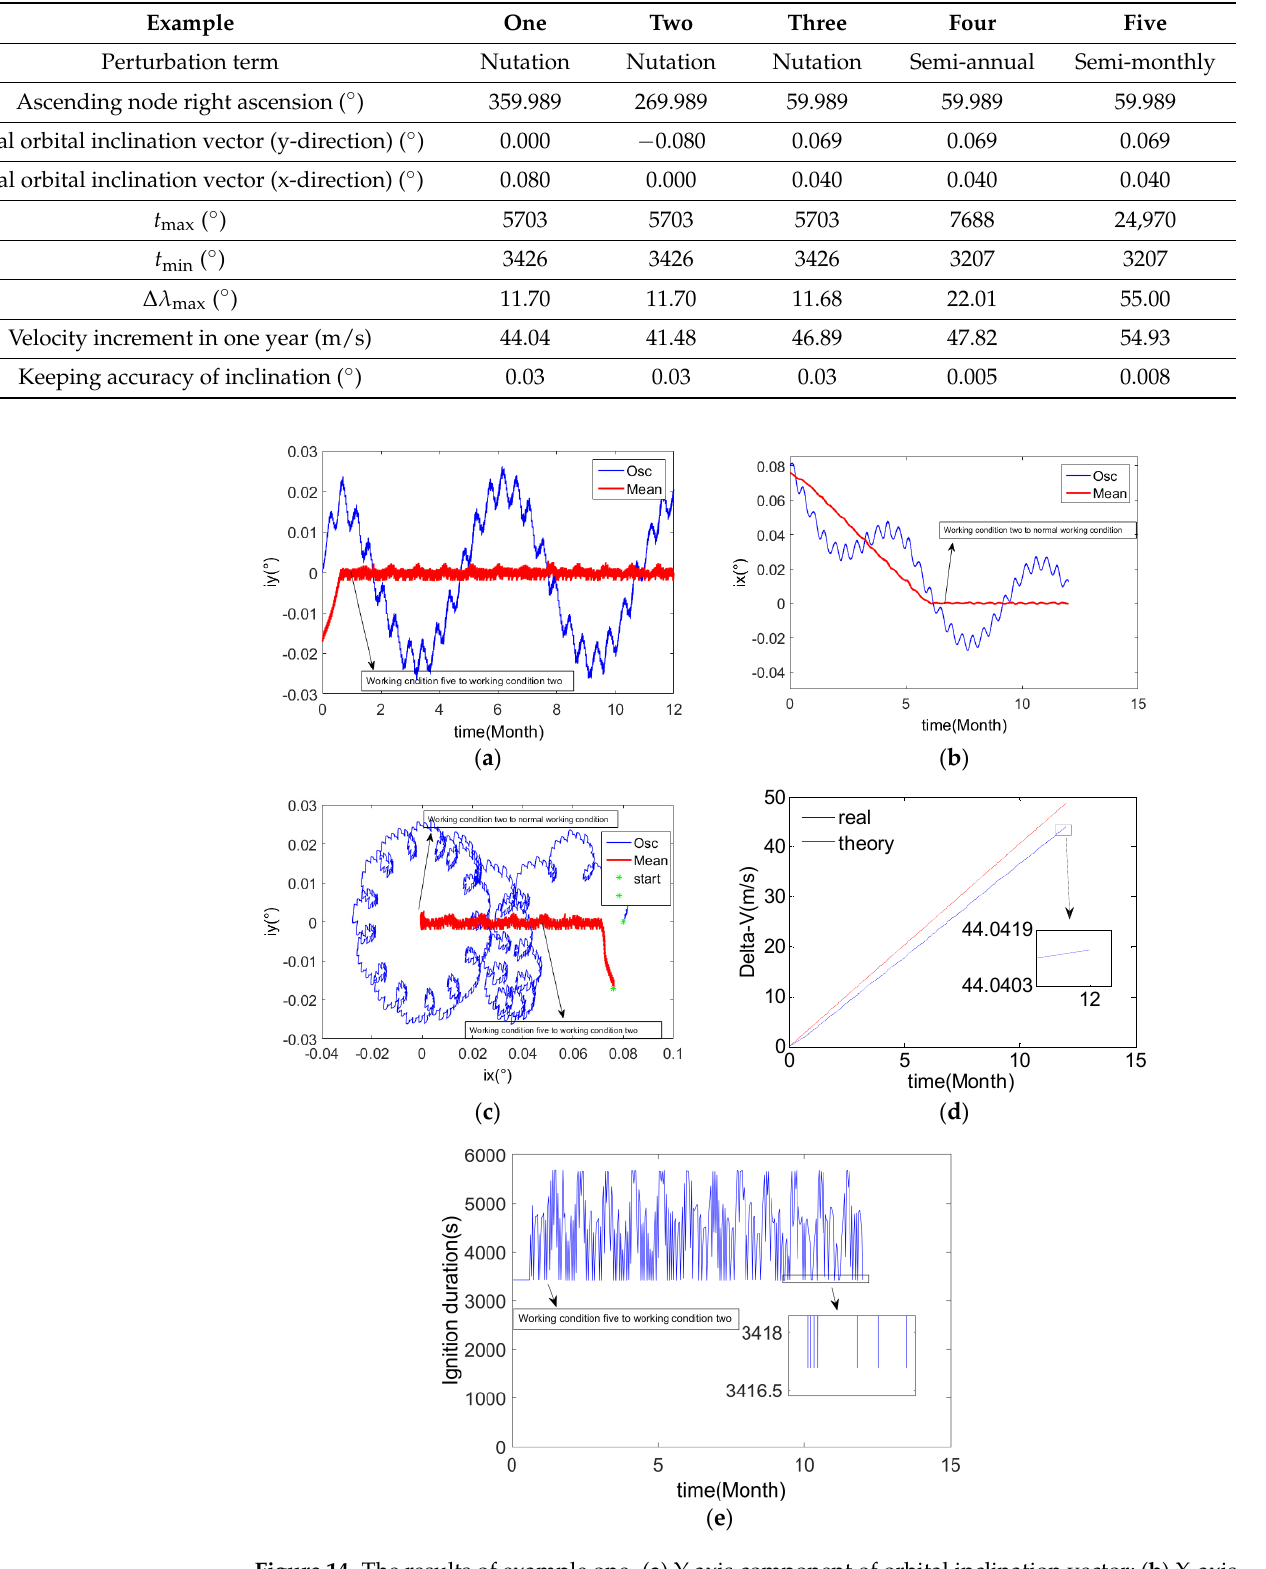
Figure 14. The results of example one. ( a ) Y-axis component of orbital inclination vector; ( b ) X-axis component of orbital inclination vector; ( c ) Orbital inclination vector; ( d ) Velocity increment for SK; ( e ) Duration of SK.